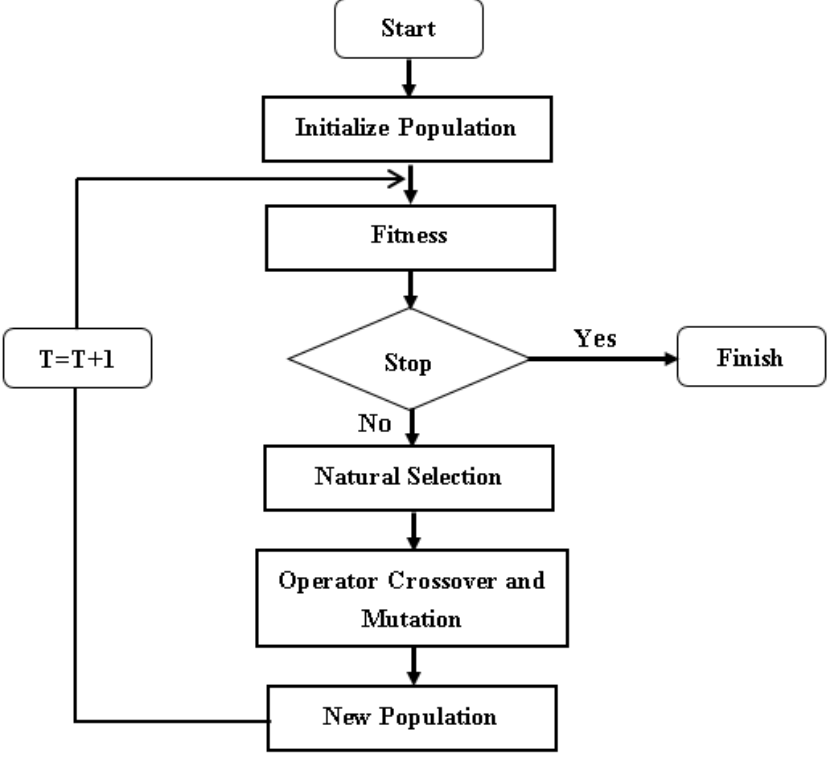
Figure 12. Schematic representation of the genetic algorithm.